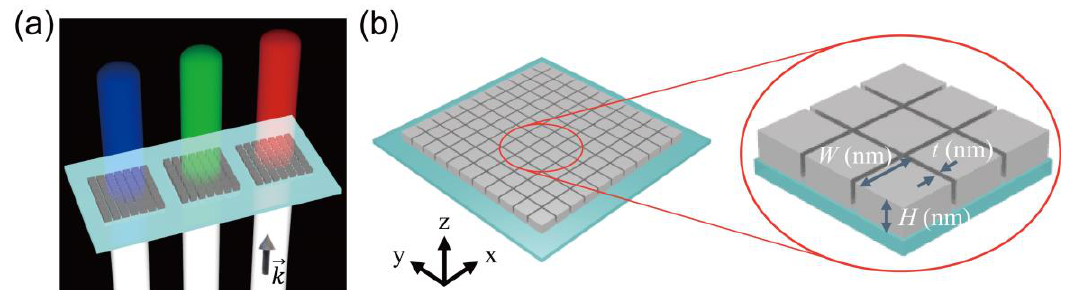
Figure 1. ( a ) Schematic diagram of proposed nanostructures, showing red, green, and blue transmissions; ( b ) Detailed view of the air slot structure embedded in silver blocks. The entire structure consists of silver blocks placed on silica substrate. Each silver block is defined by two parameters: width ( W ) and height ( H ). The slot thickness ( t ) is the size of air gap between two silver blocks.